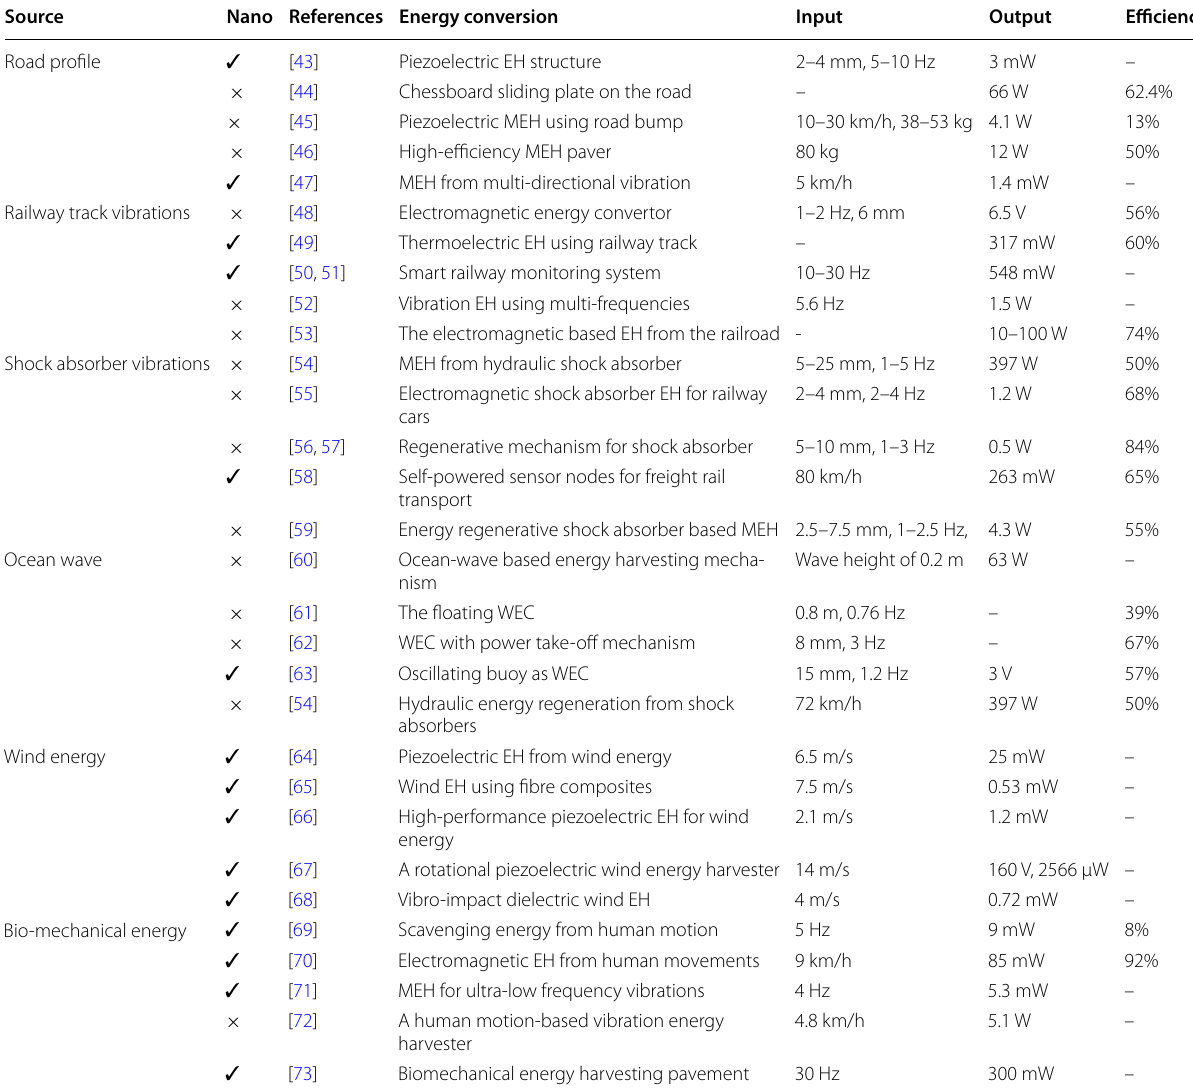
Table 1 Distribution and significance of nano-mechanical energy harvesting systems over various renewable energy sources of MEH and categorization concerning output